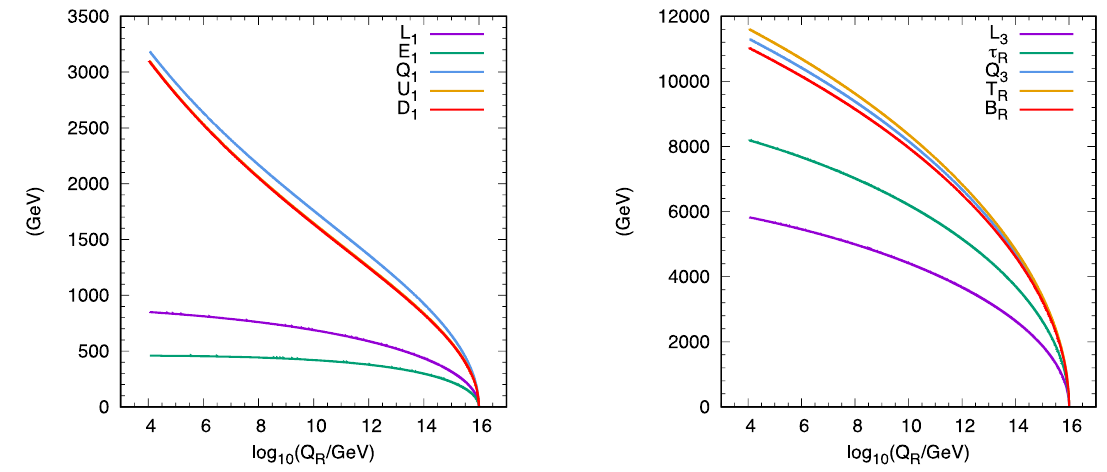
Figure 3 . RG evolution of the sfermion soft masses in gaugino+Higgs mediation. The left (right) panels are for the (cid:12)rst (third) generation (the smuon masses are only slightly heavier than the selectron masses). We have taken M 1 = 440 GeV, M 2 = 220 GeV, M 3 = (cid:0) 2000 GeV, m 2 (cid:0) 7 (cid:2) 10 8 (GeV) 2 , and tan (cid:12) = 40.